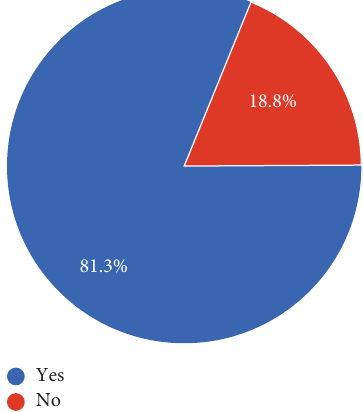
Figure 4: Te answer to the question about the early introduction of the NBC 2016 to students of architecture. Te blue is an afr- mative “yes,” and the red is a “no.” Te numbers represent